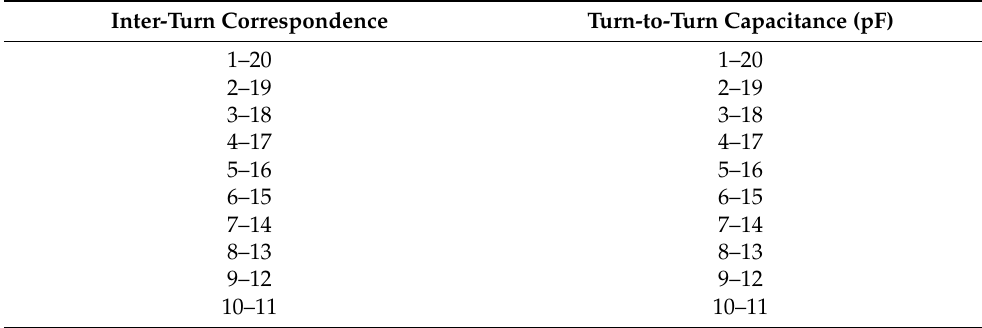
Table 4. Capacitance between turns of the top two coils.